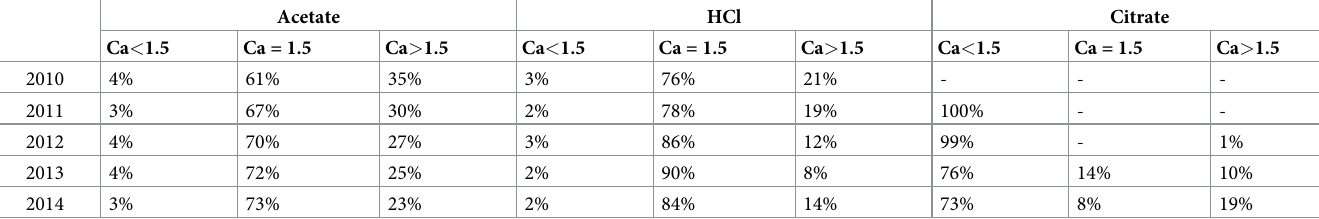
Table 2. Percentage of dialysate sales in France from 2010 to 2014, as a function of the calcium concentration and acid type. Ca <